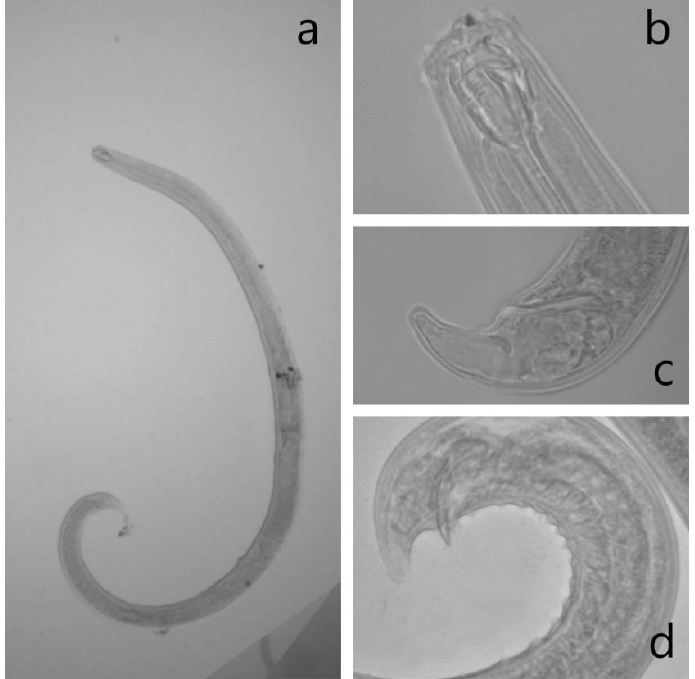
Figure A2. Mylonchulus brachyuris (Bütschli, 1873): ( a ) habitus of female, ( b ) lip region of female, ( c ) tail of female, ( d ) posterior part of male; at 200 × magnification: a, at 400 × magnification: ( b – d ). Gödöllő, Hungary.